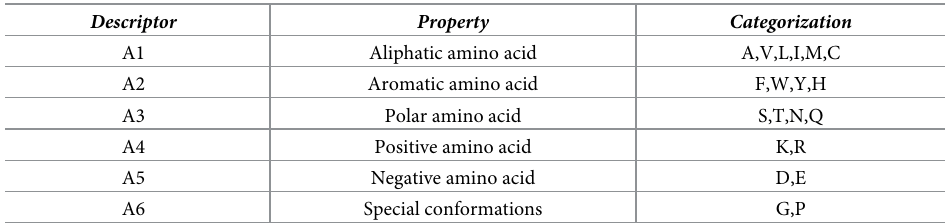
Table 1. Amino acid (Residue) categorization into 6 different